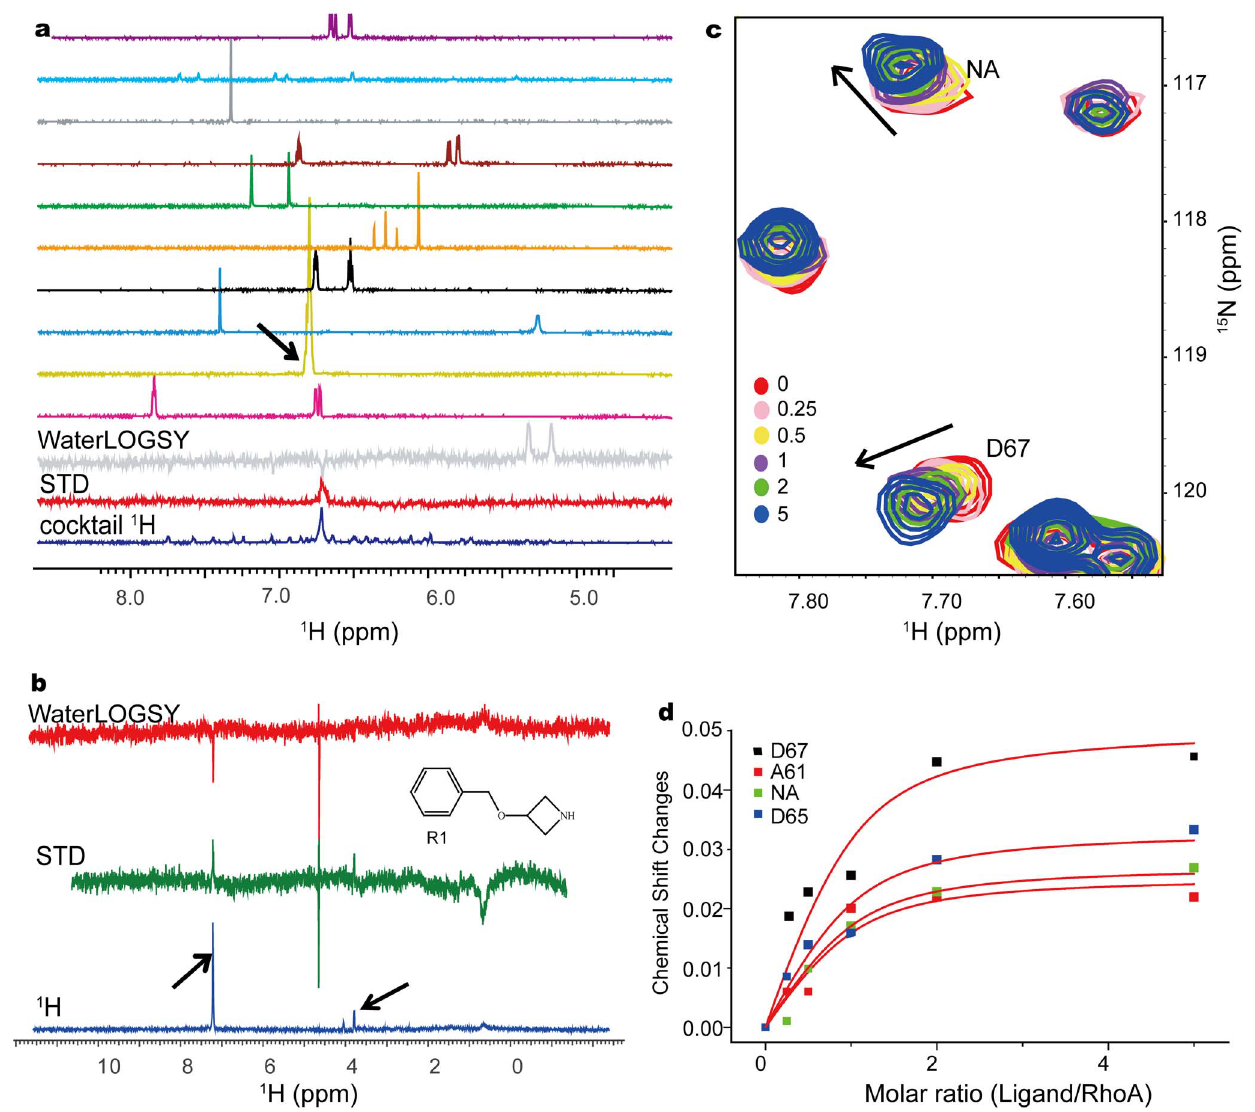
Figure 4. Fragment screening over DH/RhoA complex. a) The primary screening result for one typical cocktail, with 10 reference spectra and 3 screening spectra depicted. The arrow indicates the identified hit; b) The secondary screening over the identified hit R1 individually. c) The chemical shift perturbation in 15 N RhoA HSQC spectra induced by titration of the compound R1 with the molar ratio varying from 0.0 to 5.0, as the numbers denoted. The perturbed residues D67 and NA (not assigned) are labeled with the arrows pointing out the trend of chemical shift changes. d) The affinity of R1 to RhoA can be best-fitted from the dose-dependent titration curves for the four disturbed residues simultaneously. Chemical shift changes were calculated as [( Dd H ) 2 + ( Dd N /5) 2 )] 1/2 , where Dd H and Dd N denote the chemical shift changes for 1 H and 15 N,